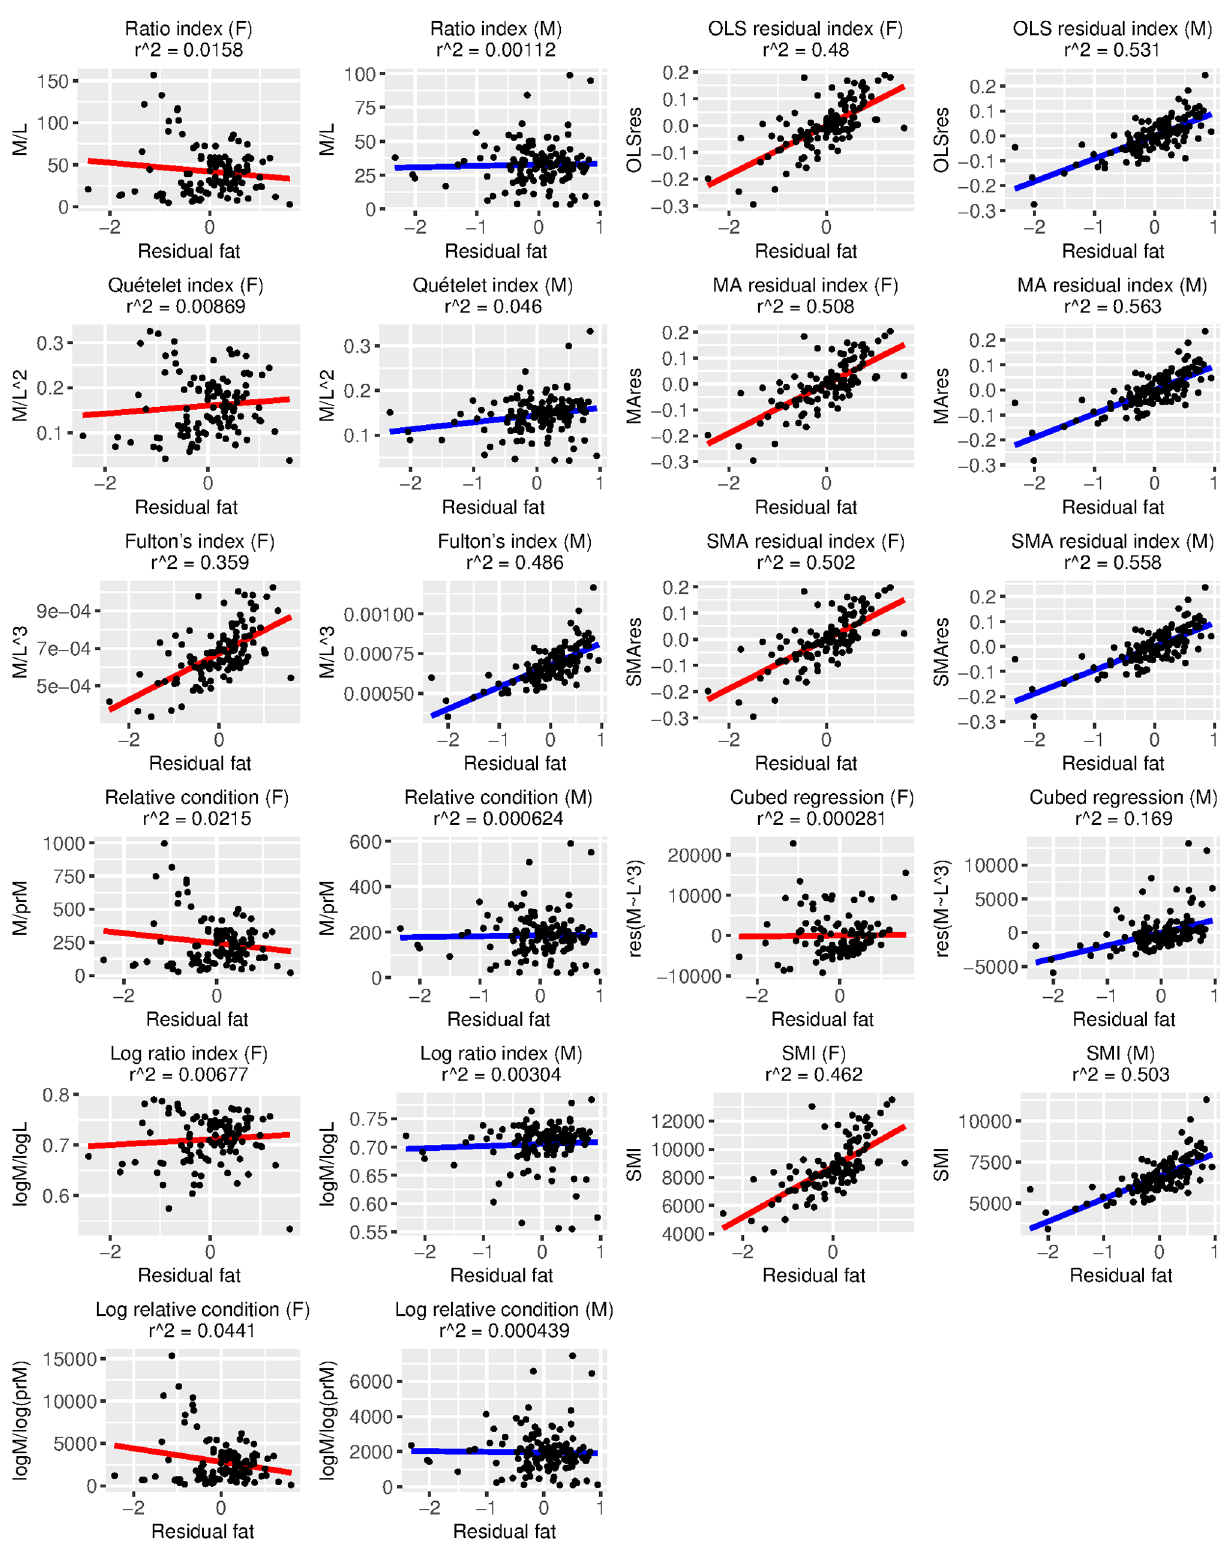
Fig 4. Relationships between 11 body condition indices (BCIs) and residual fat, a measureof true body condition, for each sex. Variationin each BCI that can be explained by residualfat is providedas an r 2 value. Ideally, most variationin a BCI should be attributable to variation in true body condition, and there should be a positive linear relationship betweenthe BCI and true body condition.Descriptions of each BCI are provided in Table 1. https://doi.org/10.1371/journal.pone.0180791.g004 PLOS ONE | https://doi.org/10.1371/journal.pone.0180791 July 19,